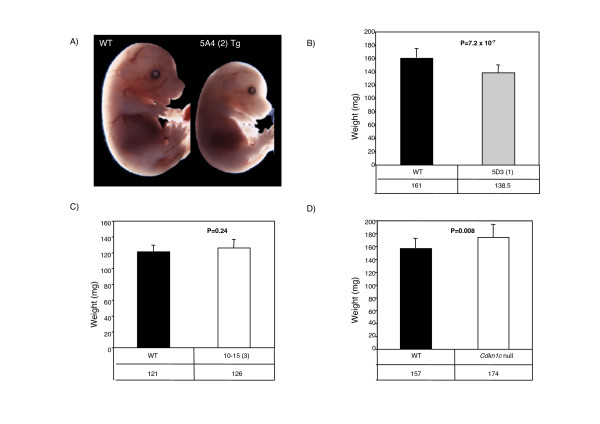
Embryonic growth is exquisitely sensitive to Cdkn1c levels. A) Image of a wild type and a transgenic embryo from line 5A4 (two copies) at E16.5 shows demonstrable growth retardation. The embryos appear normally proportioned. B) A comparison of wild type and transgenic embryo weights at E13.5 for line 5D3 (single copy unmodified BAC, Tg n = 22, WT n = 21). These embryos are from 129/Sv females mated with transgenic males maintained on an MF1 background. Transgenic embryos weigh significantly less than wild type embryos (86%, P = 7.2 × 10-7). C) A comparison of wild type and transgenic weight at E13.5 of embryos for line 10–15 (three copy BAC with an inactive transgenic Cdkn1c locus and no excess Cdkn1c, Tg n = 30, WT n = 22). The line was maintained on a 129/Sv background. Transgenic embryos are not significantly different in weight to wild type embryos (104%, P = 0.24). D) A comparison of wild type and transgenic weights at E13.5 of embryos inheriting a targeted Cdkn1c allele maternally (null for Cdkn1c, Tg n = 19, WT n = 16). The line was maintained on a 129/Sv background. Transgenic embryos weigh significantly more than wild type embryos (111%, P = 0.008).